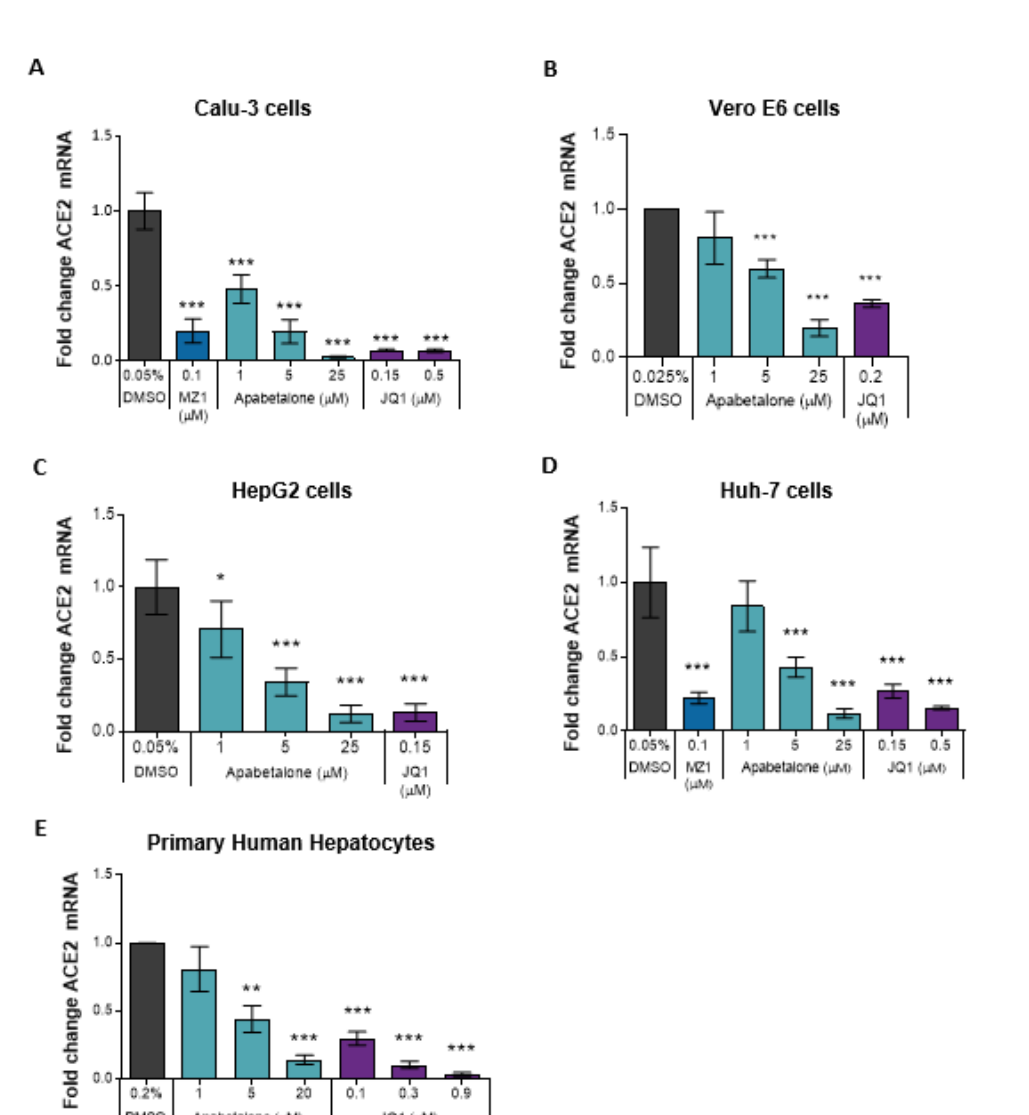
Figure 1. BETi treatment downregulated ACE2 transcript levels in various cell types. Gene expression of hACE2 ( A , C – E ) or RhACE2 ( B ) was measured by TaqMan real-time PCR. Calu-3 ( A ) were treated for 48 h, Vero E6 ( B ) were treated for 24 h, HepG2 ( C ), and Huh-7 ( D ) cells were treated for 96 h. Primary human hepatocytes (n = 3 donors) ( E ) were treated for 48 h. Error bars represent SD. * p < 0.05, ** p < 0.01, *** p < 0.001, one-way ANOVA followed by Dunnett’s multiple comparison test.